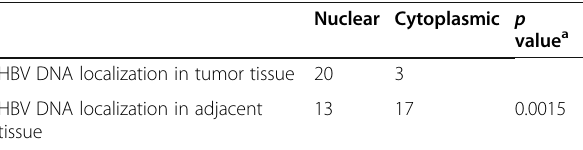
Nuclear Cytoplasmic p value a